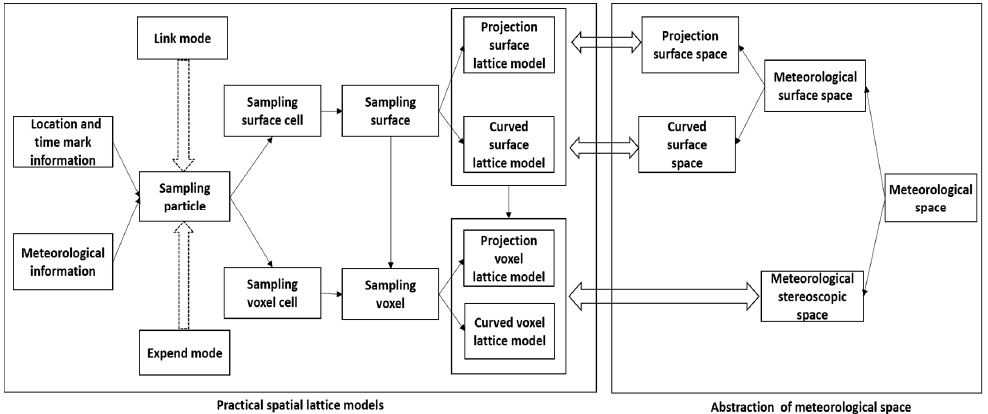
Figure 3. Design of application-oriented practical spatial lattice models.